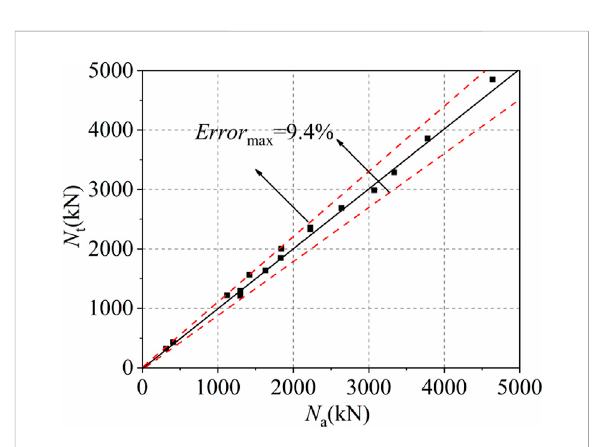
FIGURE 5 Comparsion between N a and N t for 16 test